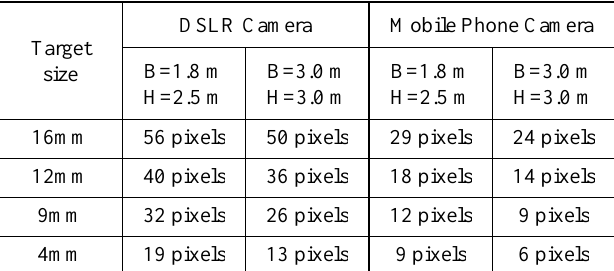
Table 3: Estimated diameter of target centres under different network configurations.